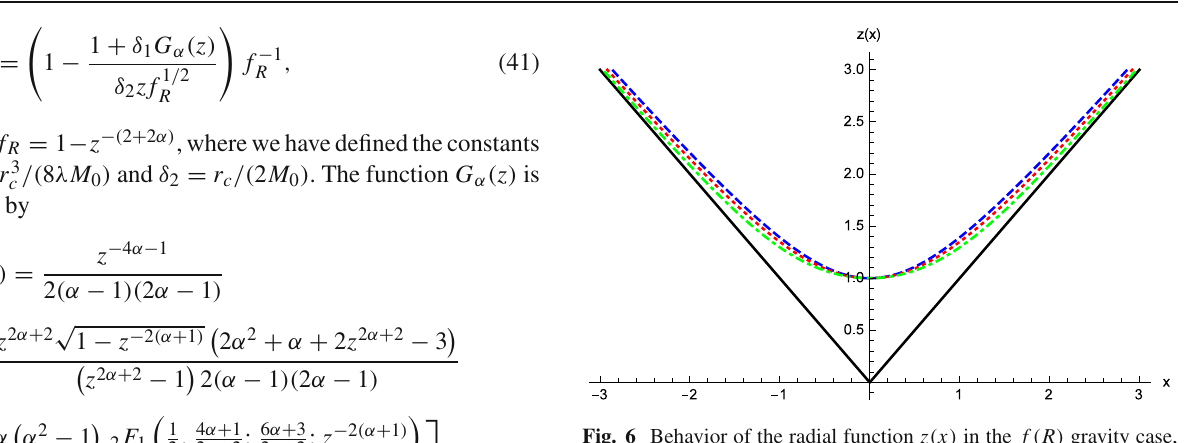
Fig. 6 Behavior of the radial function z ( x ) in the f ( R ) gravity case, obtained from Eq. (43), for the cases α = 1 / 10 , 1 / 3 , 3 / 4 (dashed blue, dotted red and dotted-dashed green, respectively)). At x (cid:13) 1 the func- tion z 2 ( x ) (cid:14) x 2 and the GR behavior is restored (straight solid black line). Observe the bouncing behavior of all these curves at x =